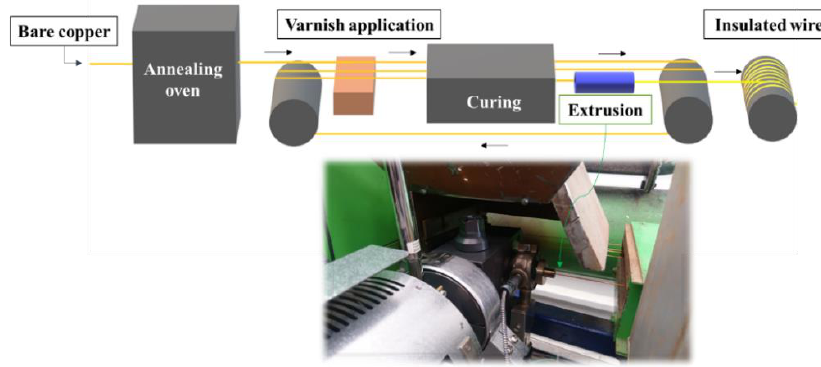
Figure 1. Insulation layer application process.